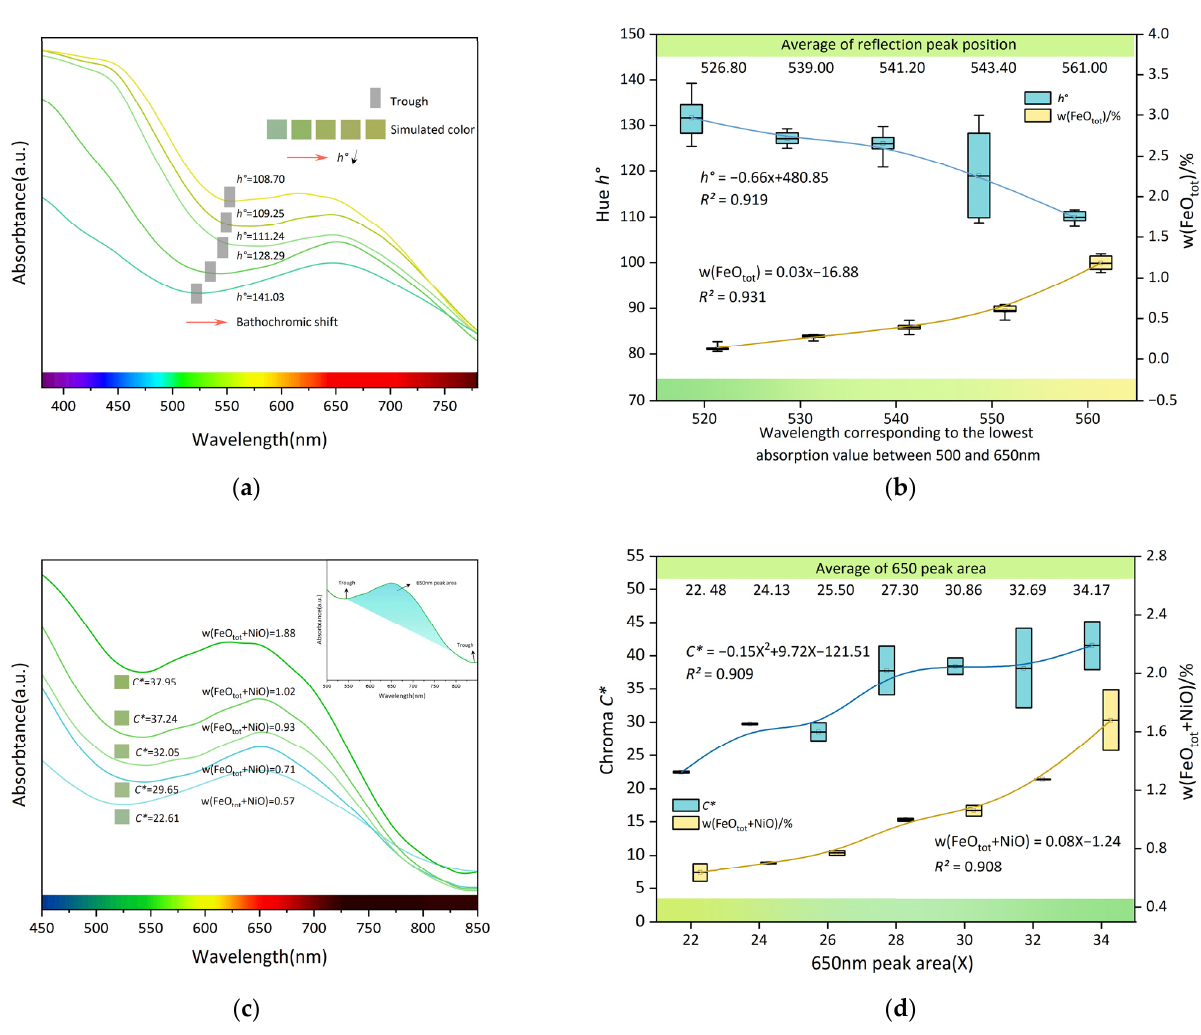
Figure 6. The body color of yellow-green opal is significantly related to the lowest absorption value between 500–650 nm and the area of the 650 nm absorption peak. ( a ) The troughs between 500 and 650 nm determine the hue h° of the opal; ( b ) The relationship between the wavelength corresponding to the lowest absorption value at 500–650 nm and the hue h° and w(FeO tot )/%; ( c ) The chroma C* and w(FeO tot + NiO)/% of opal increase with the increase of 650 nm absorption peak area; ( d ) The relationship between 650 nm peak area and chroma C* , w(FeO tot + NiO)/%.